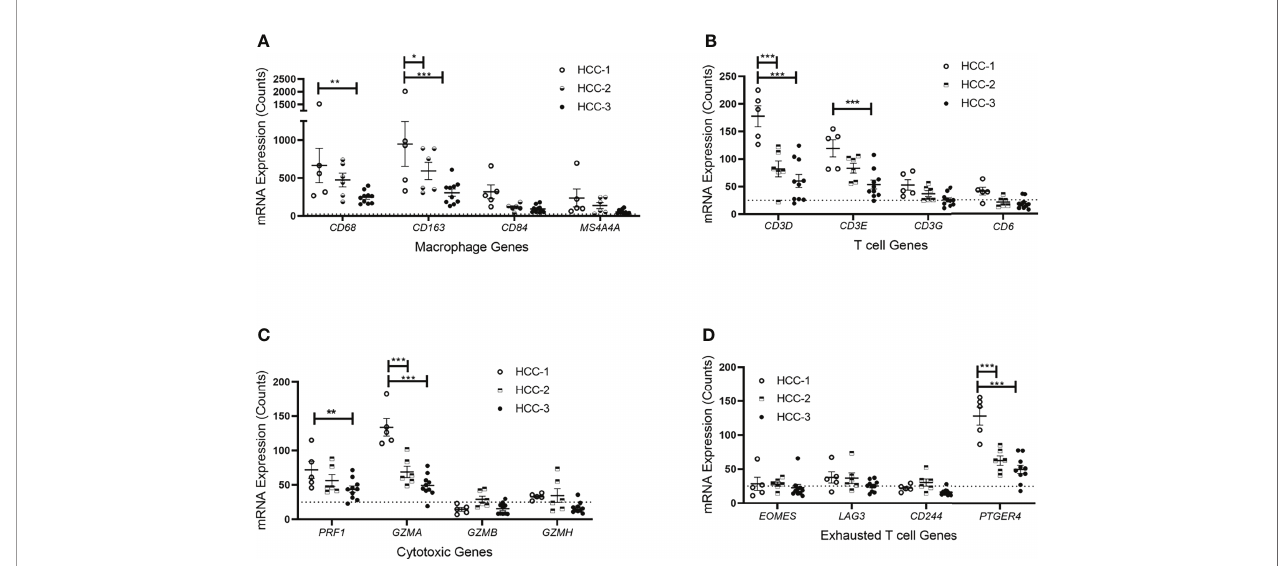
FIGURE 3 | Immune cell type-related gene expression of HCC tumors based on subtype. mRNA expression counts for genes within each cell type including (A) macrophages, (B) T cells, (C) cytotoxic T cells, and (D) exhausted T cells grouped by subtype. Dotted line represents gene expression counts below background thresholds. *P < 0.05, **P < 0.01, ***P < 0.001.